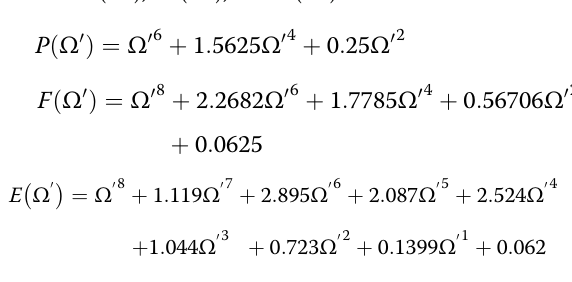
Table 2 Polynomial roots of the eight-order dual-band filter Functions Transmission zeros, the roots of P ( Ω ′ )